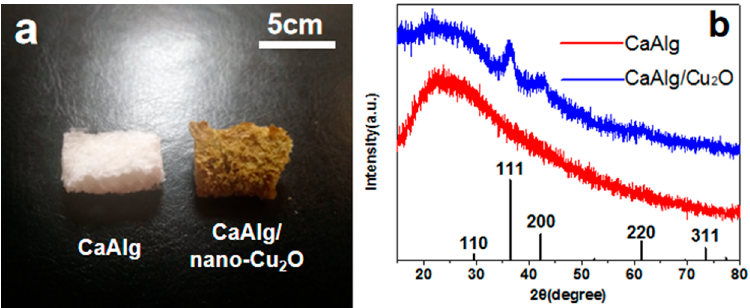
Figure 2. Digital photos ( a ) and X-ray diffraction (XRD) patterns ( b ) of CaAlg and CaAlg/nano-Cu 2 O.